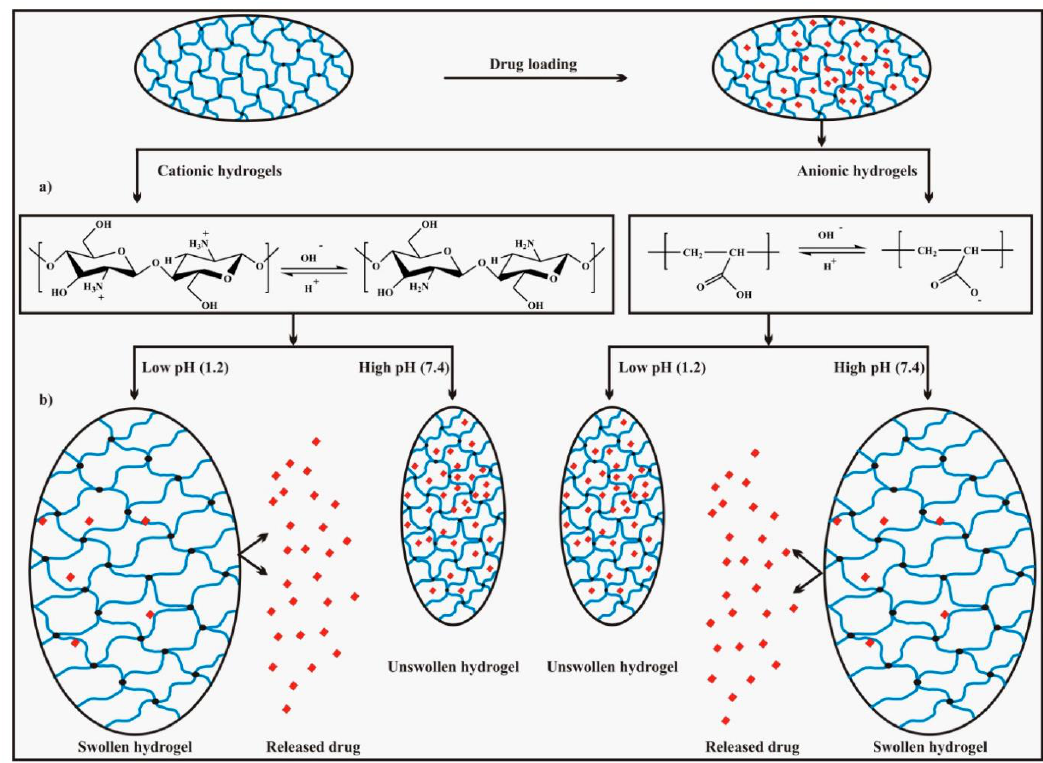
Figure 4. ( a ) pH-dependent ionization of specific acidic or basic functional groups on hydrogel chains responsible for swelling, ( b ) pH-dependent swelling, and drug release mechanism. Reproduced from